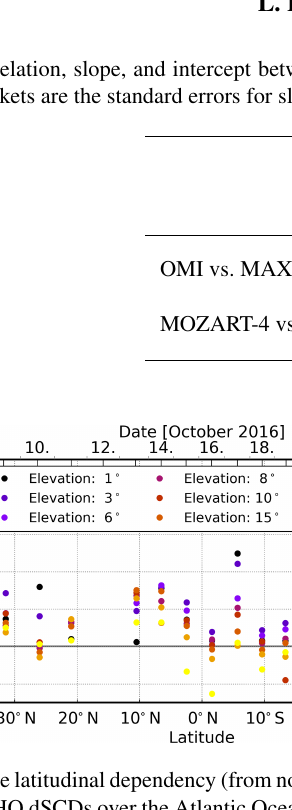
lower elevation angles are above the detection limit (17 and 21 October). Here, CHOCHO might be located closer to the